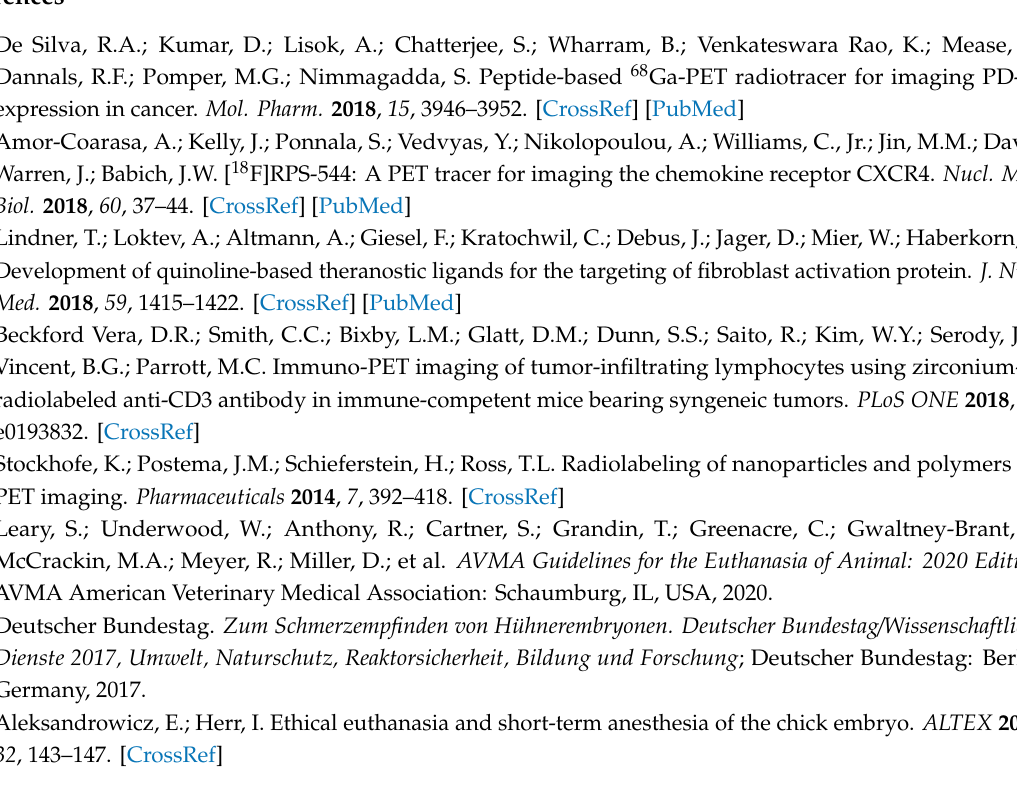
Table S1: Overview on chick embryo, Table S2: Gamma counter raw data and activity concentration ratios (PSMA + / PSMA − ), Table S3: Gamma counter data [%IA and activity ratios (PSMA + / PSMA − ) based on %IA and on PET data, Table S4: Values of the activity concentration ratios (Tumor / total) and the uptake concentration in [%IA /